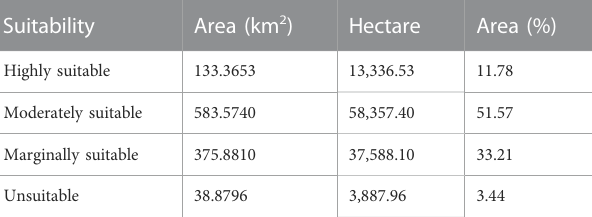
TABLE 12 Overall surface irrigation suitability of the Chacha